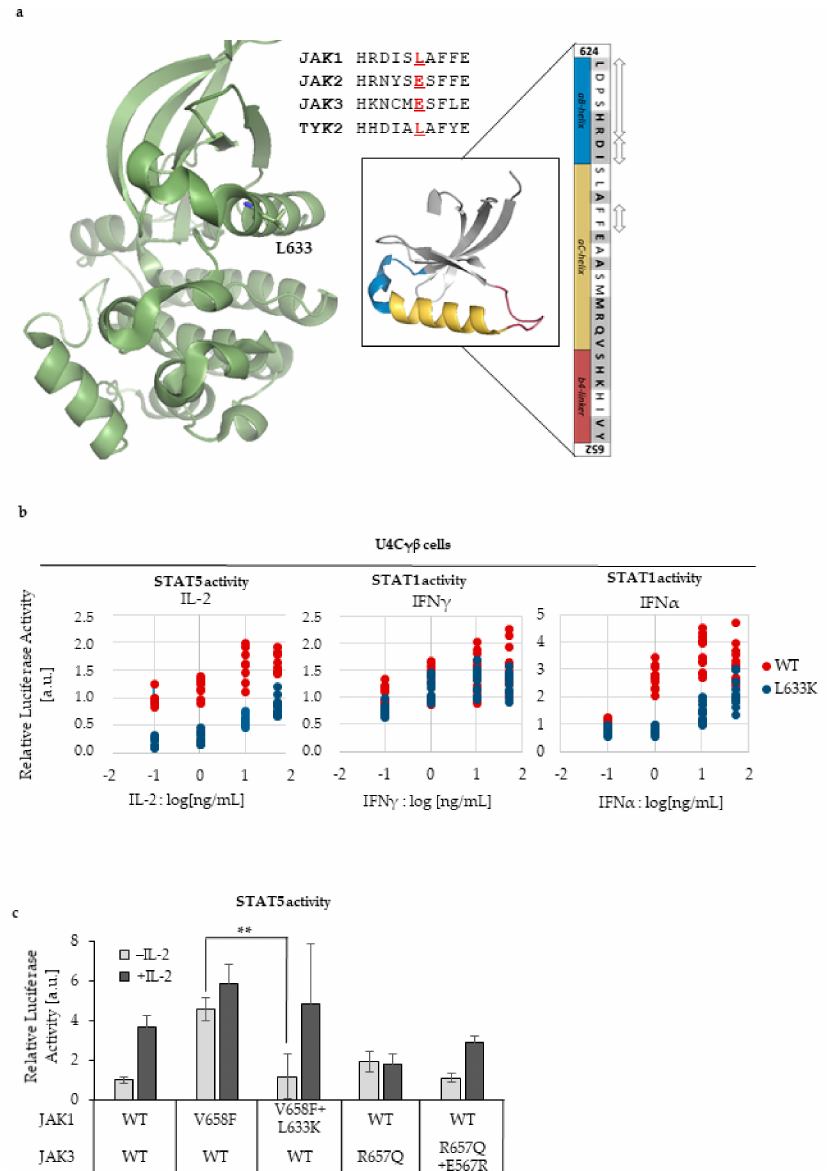
Figure 2. Analysis of the JAK1 JH2 α C-mutation. ( a ) JAK1 JH2 (PDB 4L00) structure is shown with the L633 in the α C-helix. The sequence around JAK1 L633 in JAK family is shown. Right: Mutations in the JAK1 α C-region including the adjacent α B-helix and the β 4-linker. The mutations (shaded residues with bold letters) are derived from the review of Hammar é n et al. 2018 [17] and the Catalogue of Somatic Mutations in Cancer (COSMIC)-database [32]. Deletions are shown as arrows. ( b ) Mutation in the JAK1 JH2 α C inhibits JAK1 driven IL-2 and IFN α signaling, but has lesser e ff ect in the IFN γ -induced signaling. JAK1 WT (shown as blue dots) or JAK1 L633K (red dots) were transiently transfected with STAT1 and STAT5-responsive luciferase plasmids as described previously. The U4C γβ cells were then starved or stimulated with increasing amounts of cytokine, and the STAT-activation was detected. All 12 replicas are presented as dots in a logarithmic axis showing the cytokine amount versus the relative luciferase activity. Basal state is set to − 1. ( c ) JAK1 L633K and homologous mutation in JAK3 JH2 α C reduces hyperactivation in cis . JAK1 and JAK3 mutations were studied with (100 ng / mL) and without IL-2 stimulation in U4C γβ cells that lack JAK1 and JAK3. In comparison to the activating mutations, the double mutants had reduced basal activity and responded to cytokine stimulation similarly as JAK WT transfected cells. STAT5 activity was studied with SPI-Luc luciferase system as described previously. The errors are SD of two separate experiments both having triplicate samples ( n = 6). Two-tailed t -test was performed and **—indicates p -value <